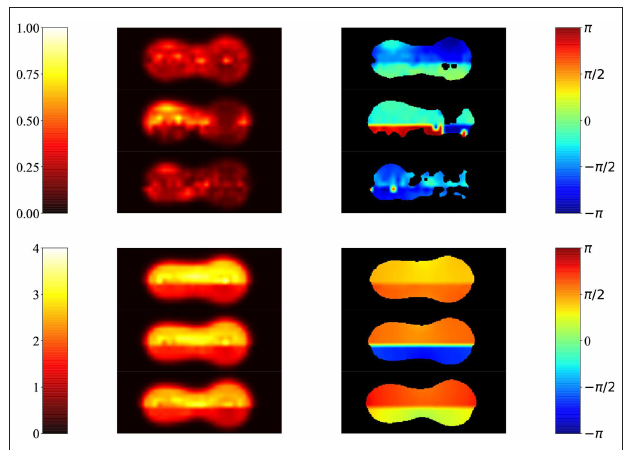
FIGURE 4 | These are some selected snapshots of the neutron/proton magnitudes (Left) and phases (Right) of pairing gaps (upper half/lower/half of each frame) in the case of realistic pairing strengths (upper panels) and enhanced pairing strength (lower panels), obtained in the case of SLy4 NEDF. This figure is adapted from the results published in Bulgac et al. [17] under the Creative Commons CC BY license.